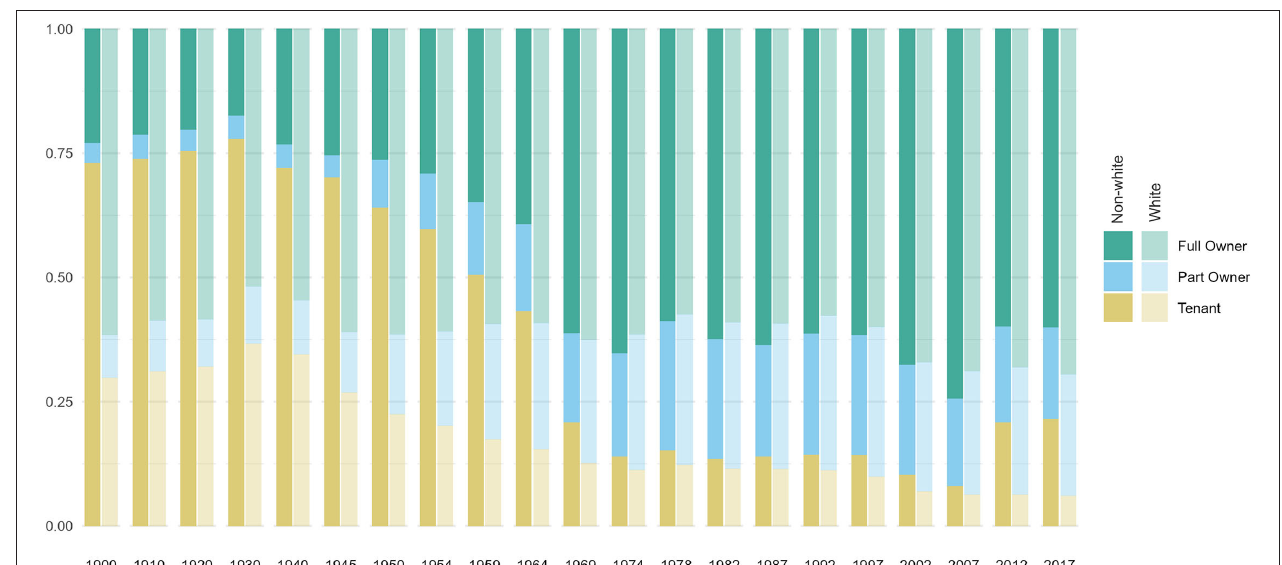
FIGURE 13 | Proportion ownership of farms by race from 1900 to 2017. In each year the left column shows the proportion of farms owned and rented by non-white operators, and the right, by white operators. Due to data limitations (i.e., historical lack of intersectionality in data collection) we can only visualize white vs. all other races. Data: ( Haines et al., 2018); distributed by